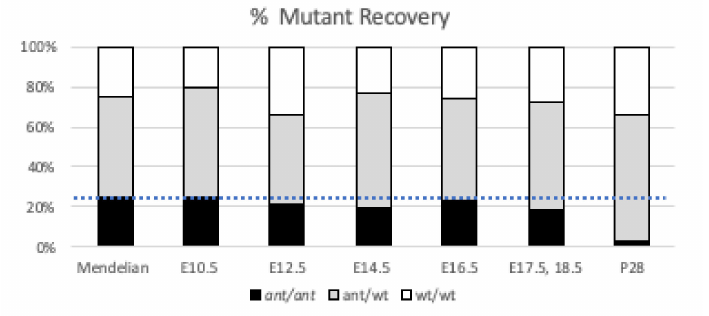
Figure 4. Survival of Cse1l ant/ant mutants. Percent of mutants recovered from all embryos at each stage analyzed with 25% Mendelian expectations show with blue dotted